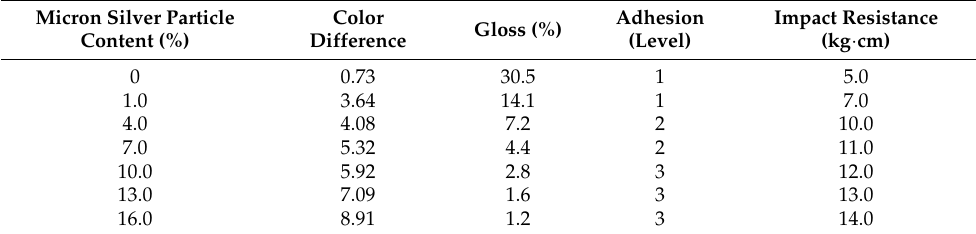
Table 5. Performance of primer film with different concentrations of micron silver